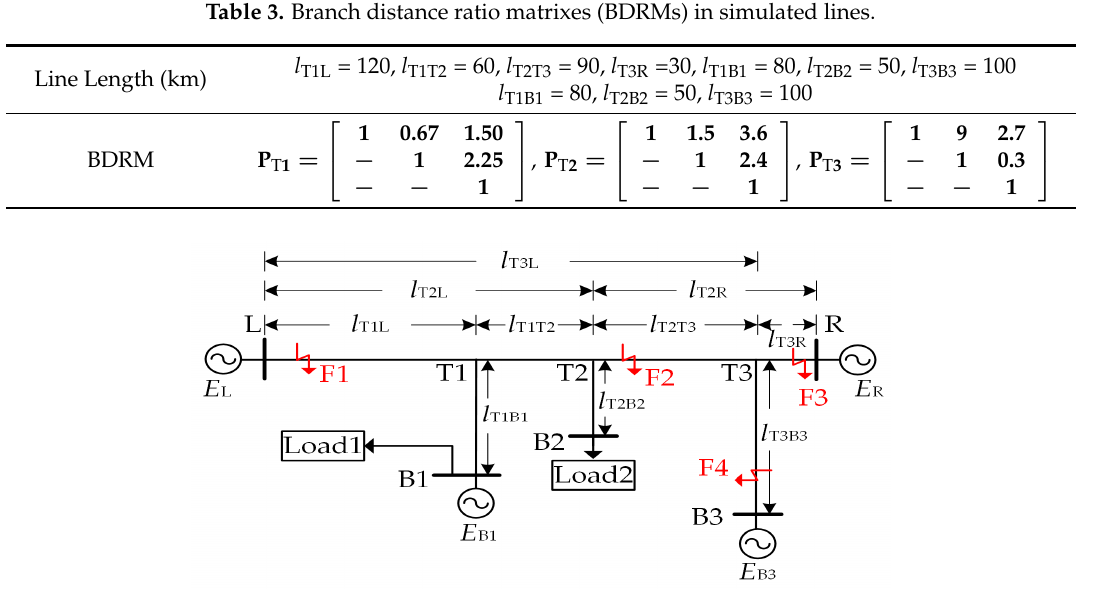
Figure 8. Five-terminal lines simulation system.